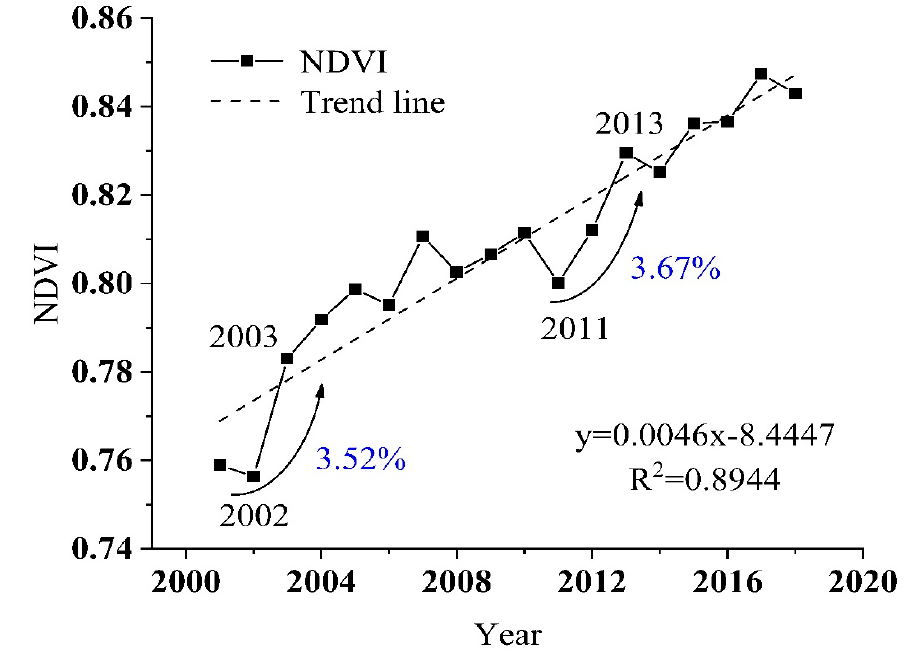
Figure 2. Variations of NDVI in the HJRB from 2001 to 2018. Table 3. Area ratio of di ff erent NDVI levels